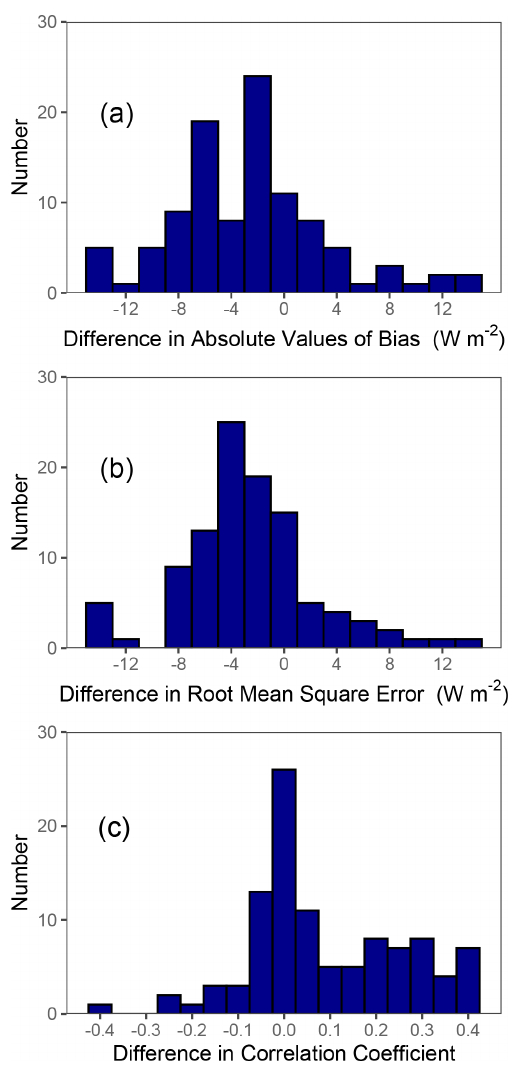
Figure 5. Histograms of the difference of (a) absolute values of bias, (b) root mean square error, and (c) correlation coefficient be- tween SunDu-derived surface incident solar radiation ( R s ) and ob- served R s before and after homogenization. Their differences de- crease after homogenization.